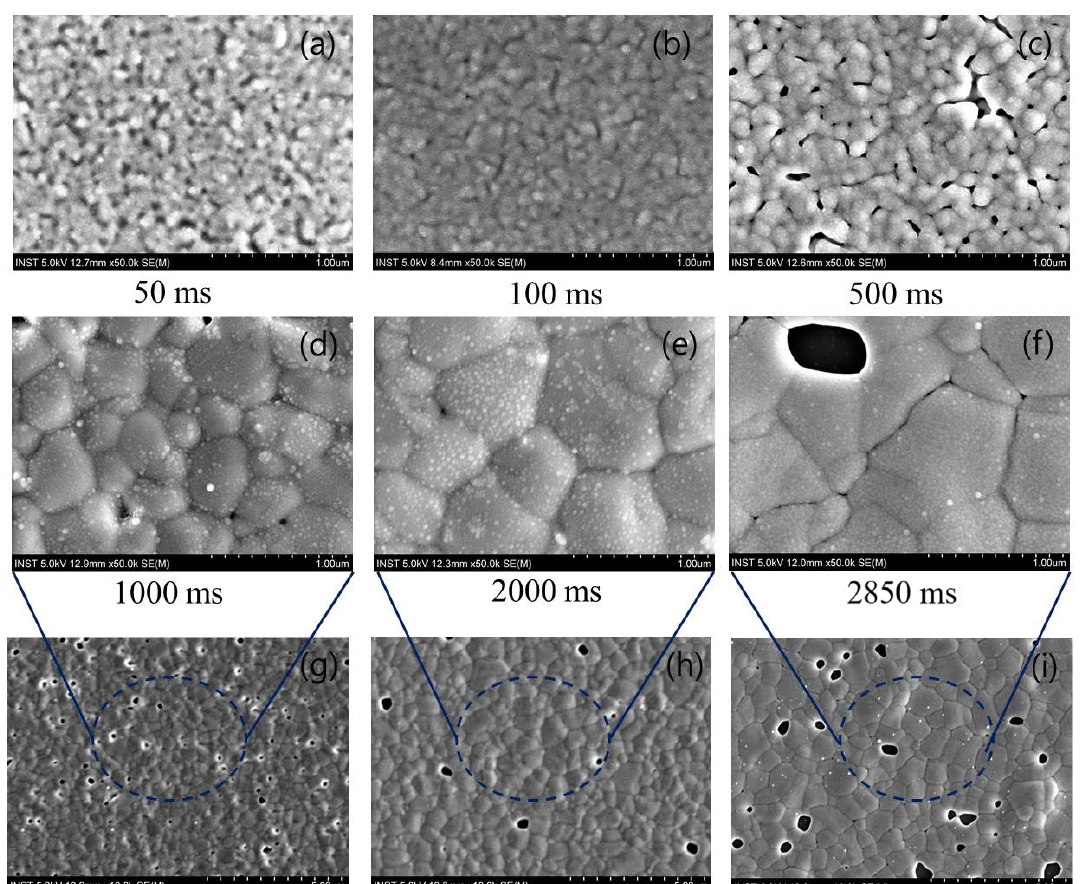
Figure 7. FE-SEM images of inkjet-printed silver nanoparticles sintered at the final-step current of 0.5 A at time durations of ( a ) 50 ms, ( b ) 100 ms, ( c ) 500 ms, ( d ) 1000 ms, ( e ) 2000 ms, and ( f ) 2850 ms, respectively. The images at the middle reveal 10,000× SEM images measured after sintering at final-step currents for 1150, 2150, and 2850 ms, respectively ( g – i ).